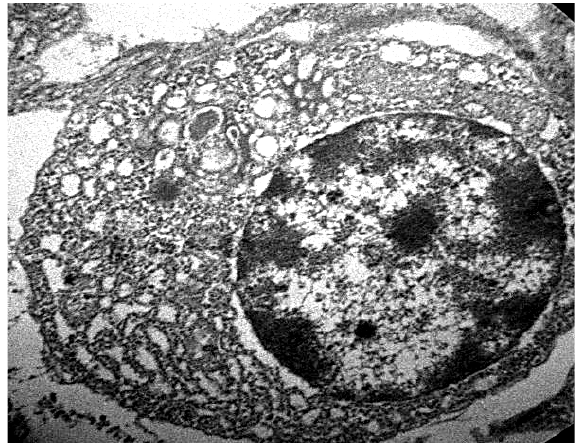
Fig. 8. Electrogram of broiler chicken’s plasmocytes, the 4 th (control) group, the 30 th day of the test. Expansion of endo- plasmic reticulum tubules, degranulation. x 8000. Fig. 6. Moderate pyroninophilicity of chicken’s Bursa of Fabricius plasmocytes cytoplasm, the 4 th (control) group, the 30 th day of the test. Brache. x 400